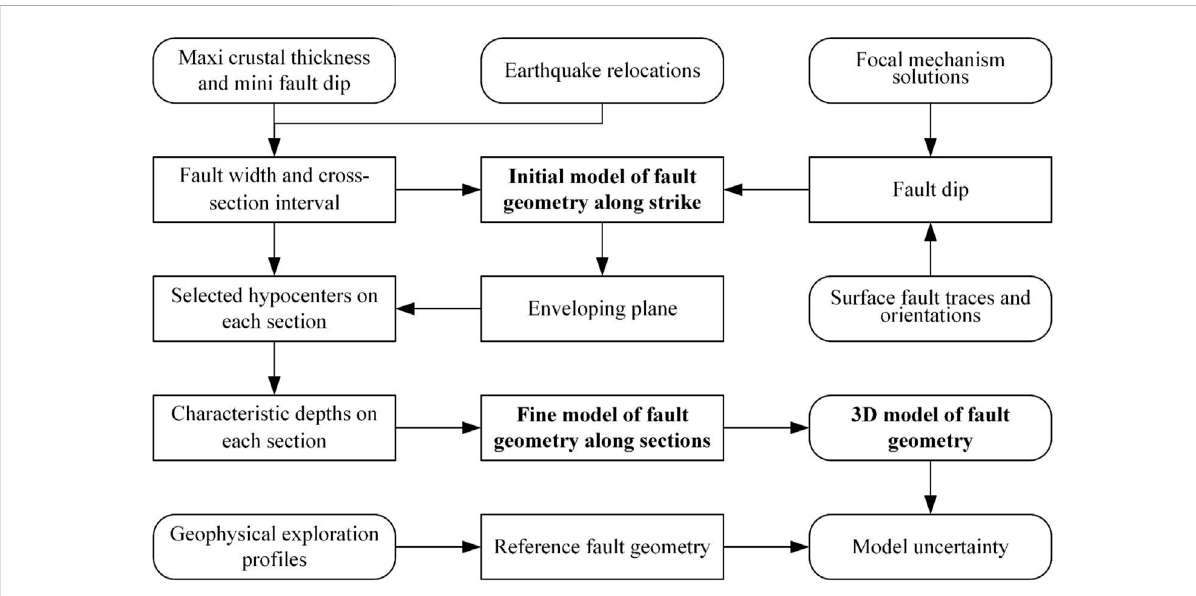
FIGURE 2 The work fl ow of 3D fault geometry modeling. The main stages are as follows: 1) the potential maximum fault width is derived from the maximum crustal thickness and minimum fault dip in the research region. The more precise fault width can be judged according to the distributions of the relocated hypocenters within the maximum fault width. The fault dip variations are gridded within the judged fault width based on the dips re fl ected by the nodal planes of focal mechanism solutions which are selected according to the surface fault traces and orientations. The low- resolution initial model of fault geometry along fault strike is constructed according to the fault dip variations. 2) The cross-section interval along each fault strikeis evaluated bysettingrelocated hypocenternumberis not lessthan 200 oneach section within fault width. The hypocenterswithin the enveloping plane, which is with the highest hypocenter density, is used to calculate the characteristic depths on each section. The high- resolution fi nefaultgeometryalongeachcross-sectionismodeledby fi ttingthecharacteristicdepths.3)The3Dfaultgeometryismodeledbasedon the fi ne geometries along different sections, and the uncertainty of the 3D model is estimated by taking the fault geometries from geophysical interpretation results as